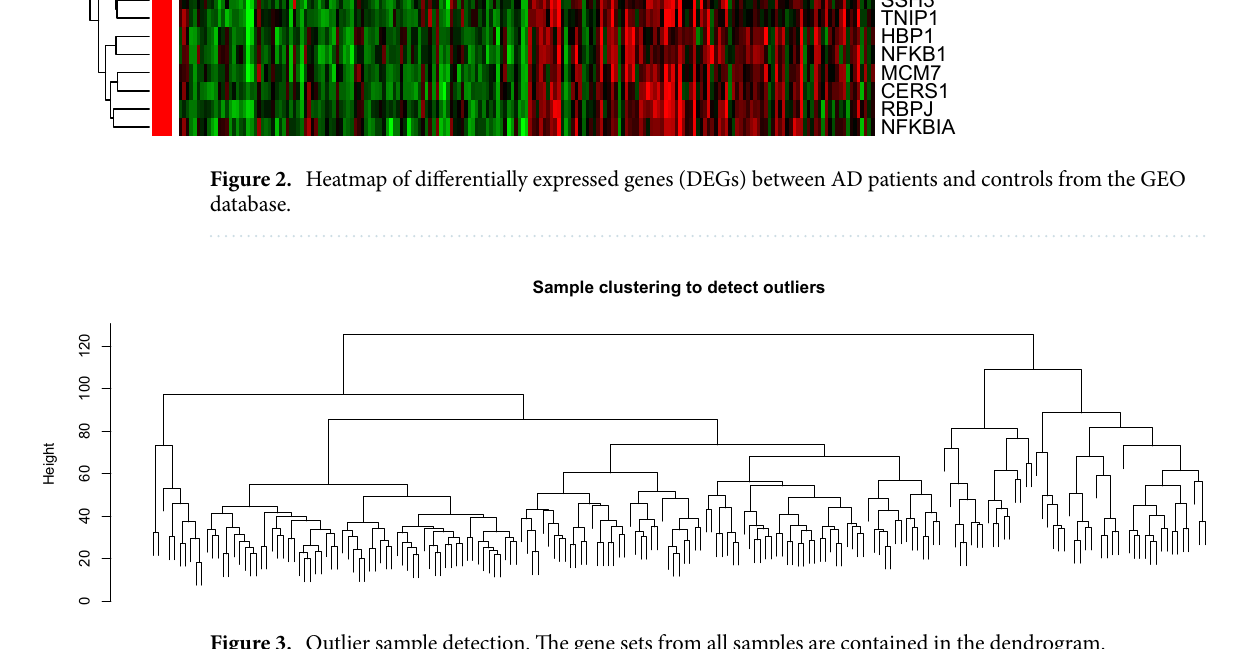
Figure 3. Outlier sample detection. The gene sets from all samples are contained in the dendrogram.